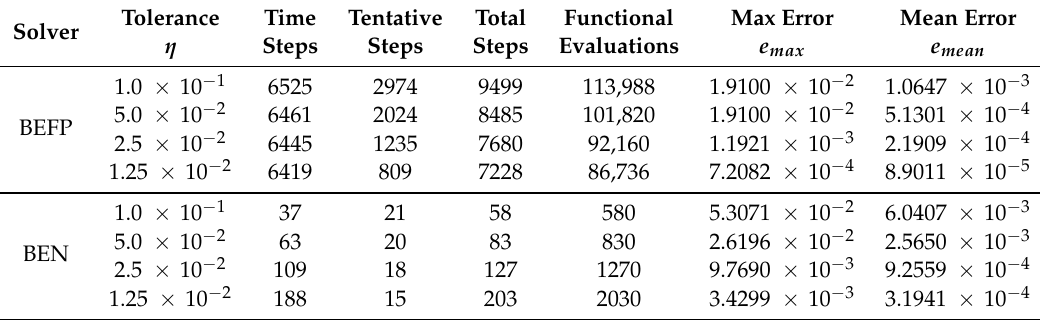
Table 9. Results of the shifted quasi linear iterative splitting for the MCDB equation with µ = 5. Tolerance Time Tentative Total Functional Max Error Mean Error Solver η Steps Steps Steps Evaluations e max e mean 1.0 × 10 − 1 6525 2974 9499 BEFP